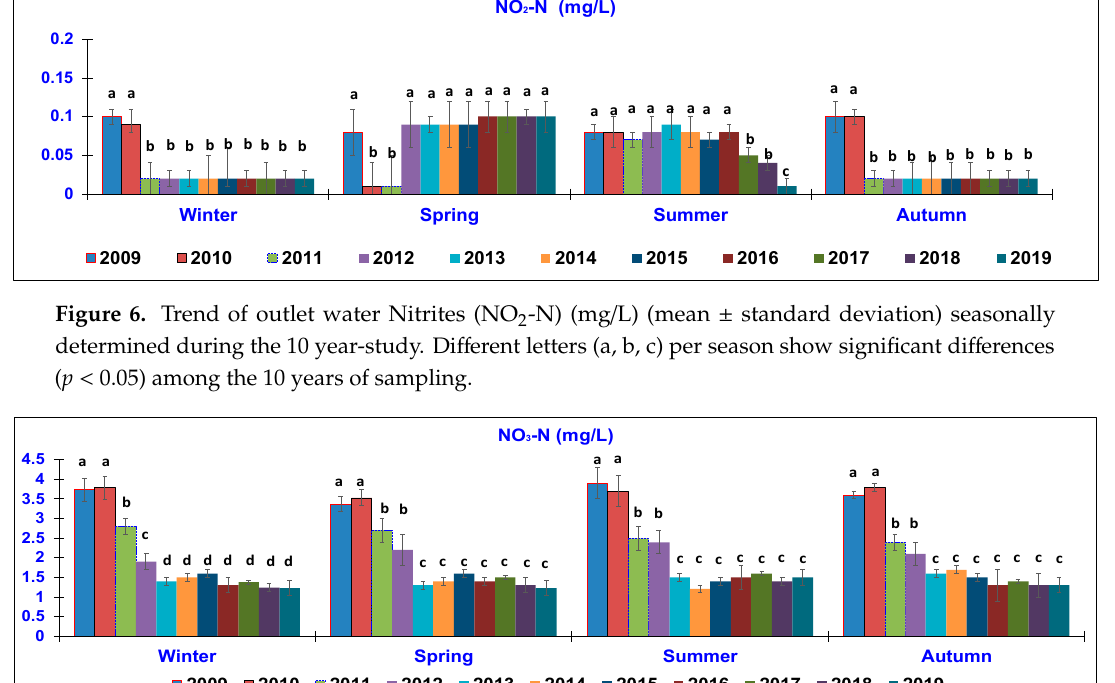
Figure 5. Trend of outlet water Total Ammonia Nitrogen (TAN) (mg/L) (mean ± standard deviation) seasonally determined during the 10 year-study. Different letters (a, b, c) per season show significant differences ( p < 0.05) among the 10 years of sampling.